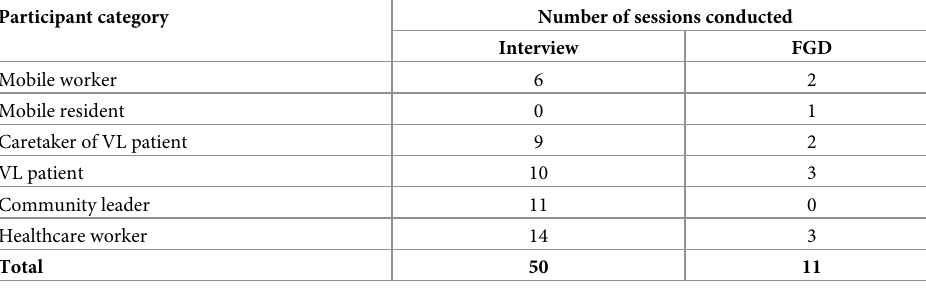
Table 2. FGD and interview sessions according to participant